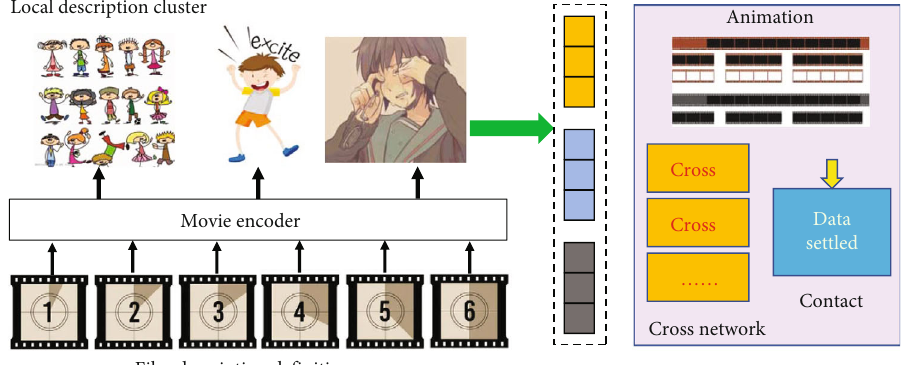
Figure 1: Animation narrative